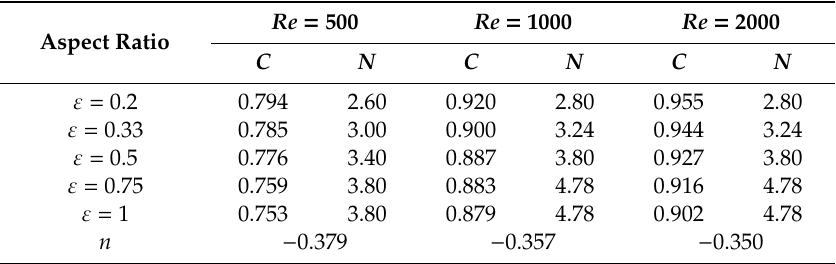
Table 1. Curve-fit parameters for Equations (20) and (22).